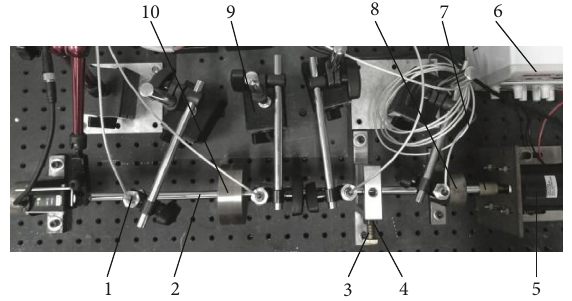
Figure 7: Experimental device: 1, eddy current sensor; 2, shaft; 3, rub screw; 4, locknut; 5, motor; 6, dc power; 7, coupling; 8, bearing seat; 9, magnetic base; 10, disc.